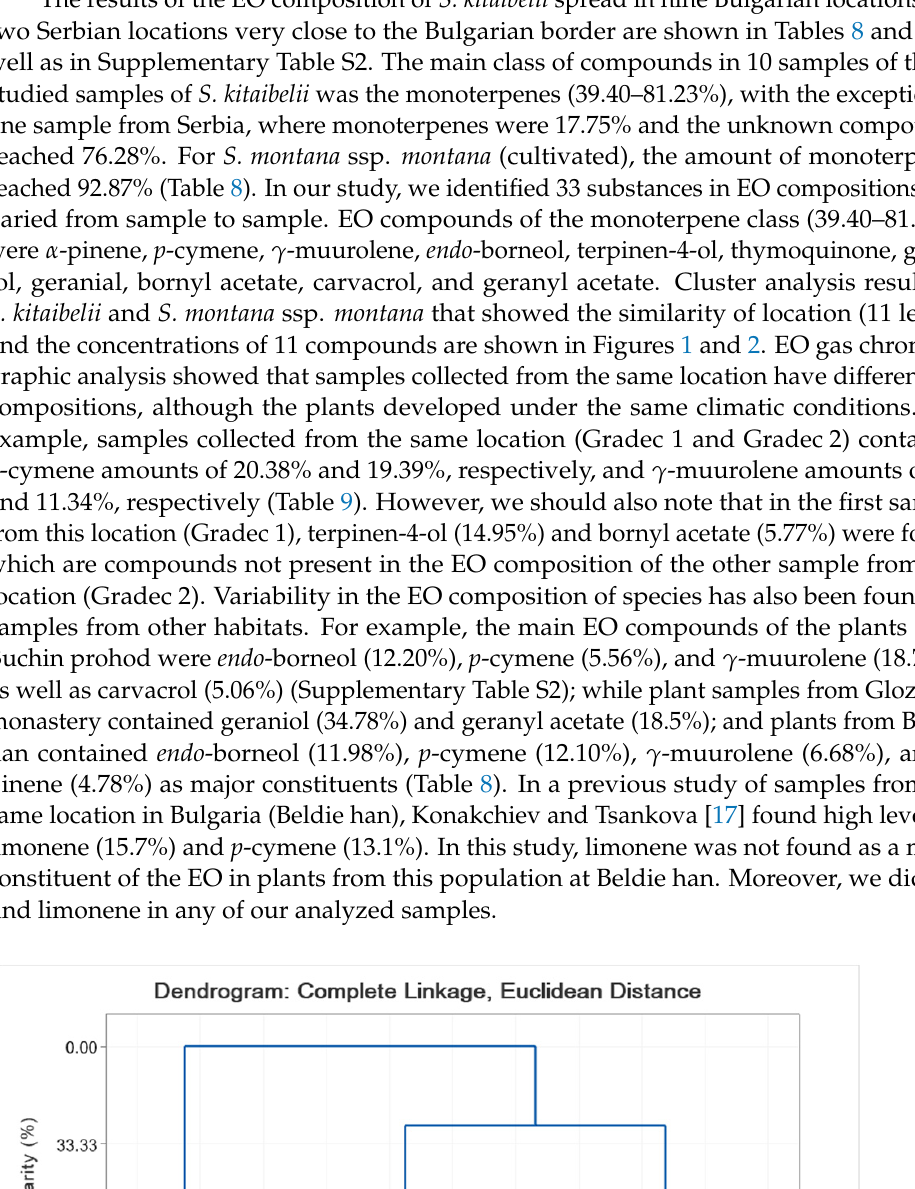
Table 9. Mean concentration (%) of α -pinene, camphene, myrcene, p -cymene, cis - β -ocimene, γ - terpinene, endo -borneol, trans -caryophyllene, γ -muurolene, spathulenol, and caryophyllene oxide of S. kitaibelii collected at 11 locations and S. montana (cultivated).